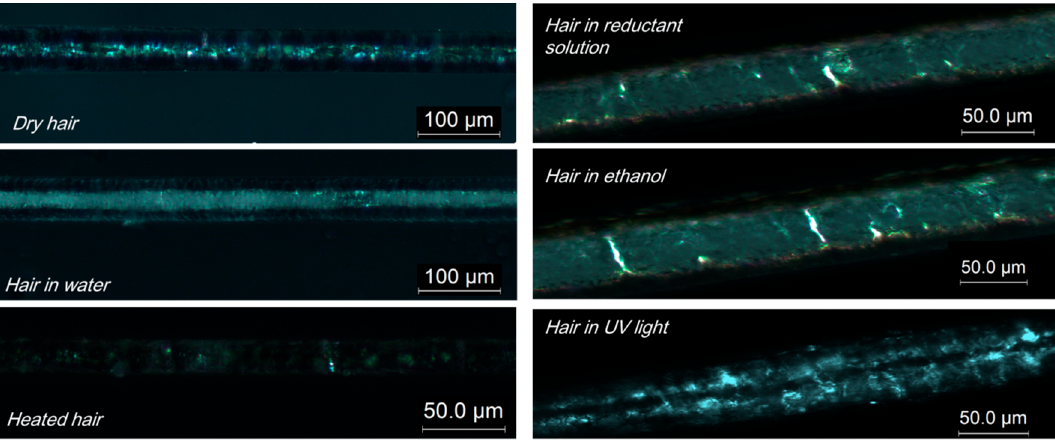
Figure 7. Images from a polarizing microscope that shows the discrete crystalline phase of different goat hairs under different